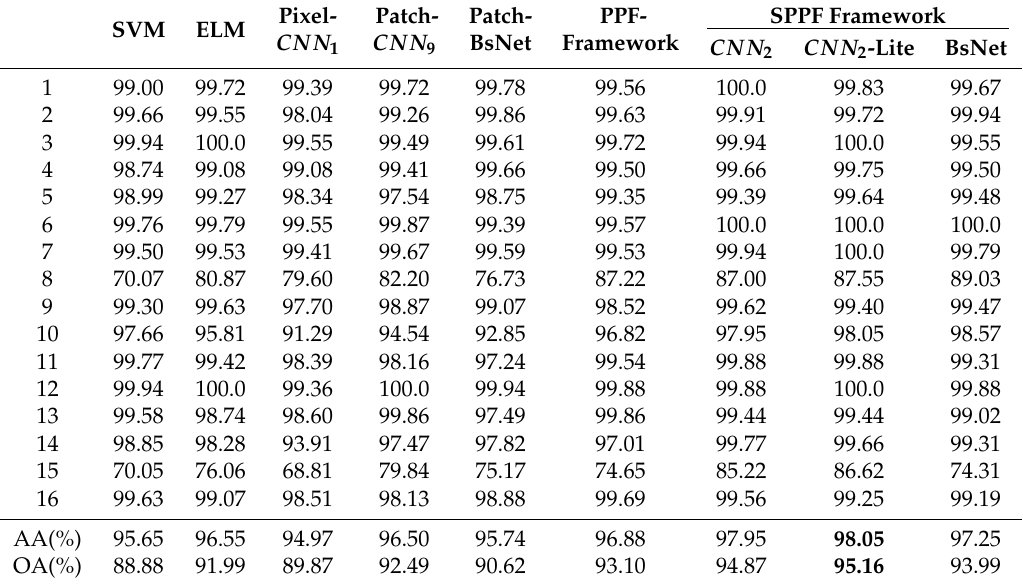
Table 10. Classification results on the Salinas dataset (accuracy shown in